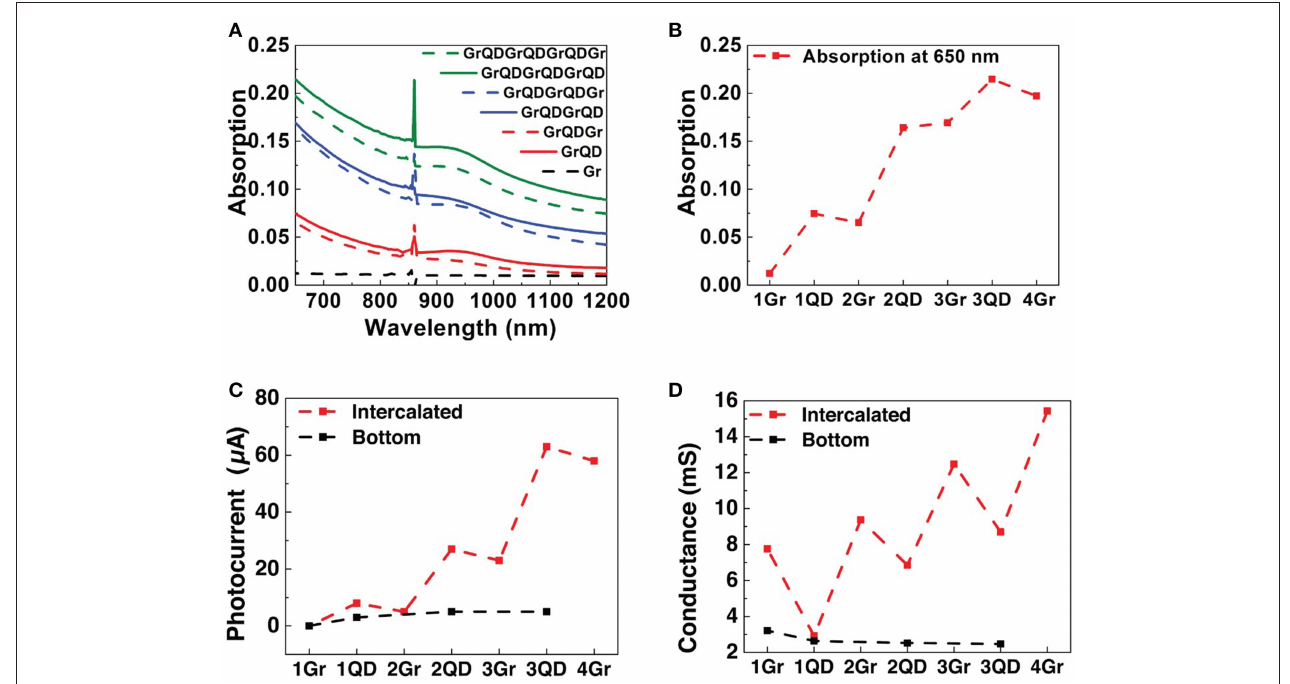
FIGURE 2 | Light absorption, photocurrent ( I ph ) and conductivity evolution in Gr/QD films. (A) Light absorption of QDs films with intercalated graphene layers. The effect of adding graphene layers is minor compared with adding QD layers. (B) Light absorption ( λ = 650nm) evolution as Gr and QD layers are added, showing strong increment when QDs are added while Gr layers produce minor changes. (C) Evolution of I ph in intercalated devices show strong increments after adding QDs and minor reductions after adding Gr with an overall net increment as Gr and QDs are added. Bottom Gr device shows only a slight increase in I ph after adding QD layers. (D) Intercalated devices show increments in conductance after adding Gr layers with smaller but still significant reductions after adding QDs. As QDs and Gr layer are added there is a net increment in conductivity. Bottom Gr devices do not show significant changes as QDs are added. Photocurrent are measured under 532nm laser diode, 0.9